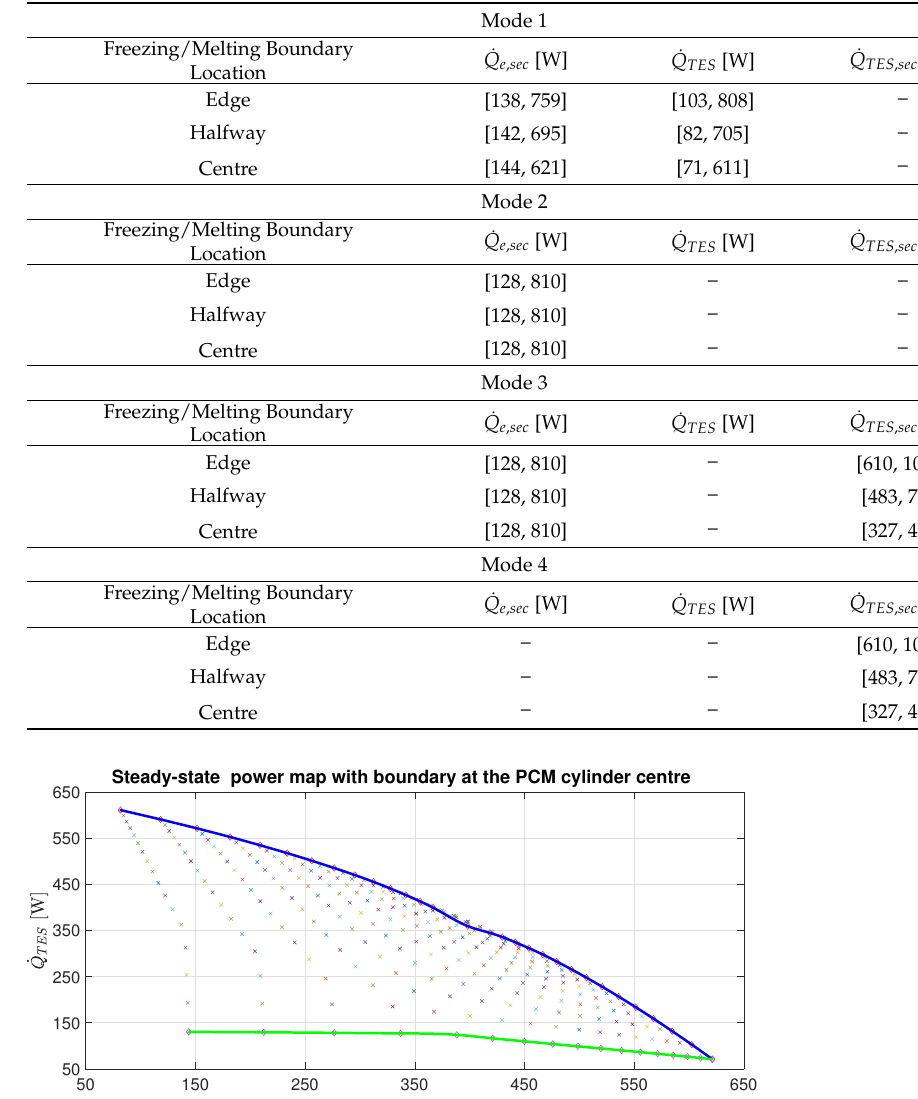
Table 4. Cooling power ranges corresponding to operating modes 1 to 4.